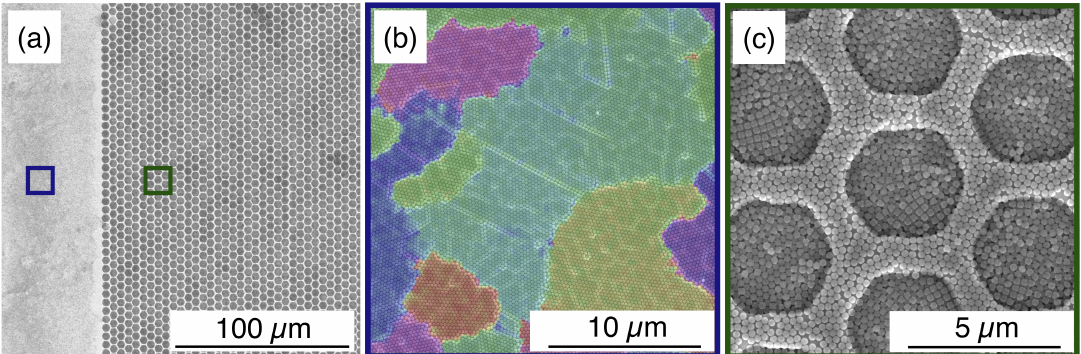
Figure 2. ( a ) Low-magnification SEM micrograph preliminarily comparing the SA of NSs on the flat and patterned area of the substrate. The blue and green frames correspond to the high-magnification SEM image ( b ) of the self-assembled monolayer, where the domains are highlighted in different colours showing a random change in the orientation from one to the other, and ( c ) inside the templates, where multiple layers are